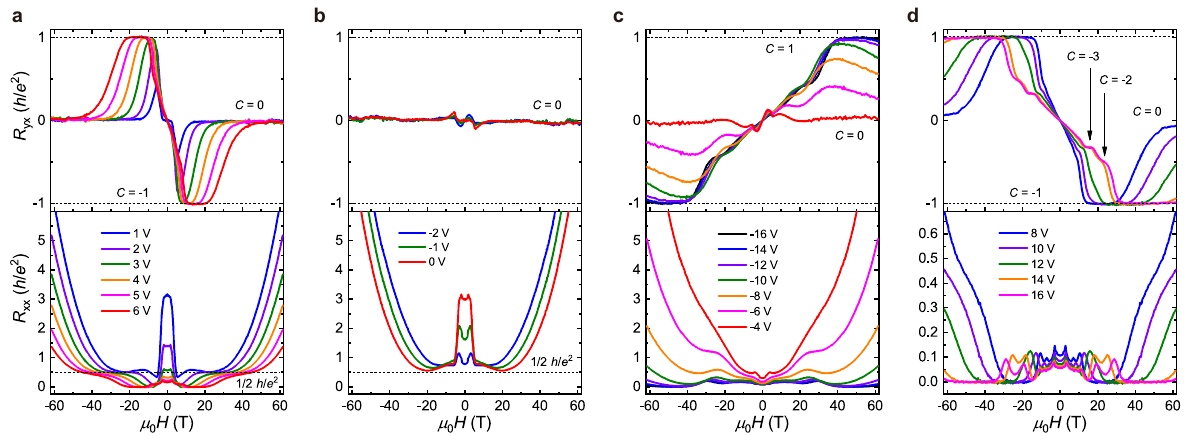
Fig. 2 Transport properties in pulsed magnetic fi eld up to 61.5 T. a Magnetic fi eld dependent R xx and R yx at 1 V ≤ V g ≤ 6 V. At V g = 4 V, the C = − 1 state is completely suppressed for μ 0 H > 30 T, followed by the C = 0 state characterized by a broad zero Hall plateau. The black dashed line denotes the R xx = 0.5 h / e 2 plateau. b Transport properties at − 2 V ≤ V g ≤ 0 V. Zero Hall plateau exist in a broad magnetic fi eld range over 50 T. c Transport behaviors in the 2D hole gas regime. With the decrease of V g , QH plateaus with a positive Chern number start to form. At V g = − 16 V, R yx forms a wide Hall plateau at h / e 2 and R xx drops to zero. d Characteristic transport behaviors of the 2D electron gas. With the increase of V g from 8 V to 16 V, the C = − 1 Hall plateau onsets at a higher magnetic fi eld, becomes broader and approaches the C = 0 plateau only at the high- fi eld limit. Electron-type QH plateaus with higher Chern numbers C = − 2 and − 3 also start to